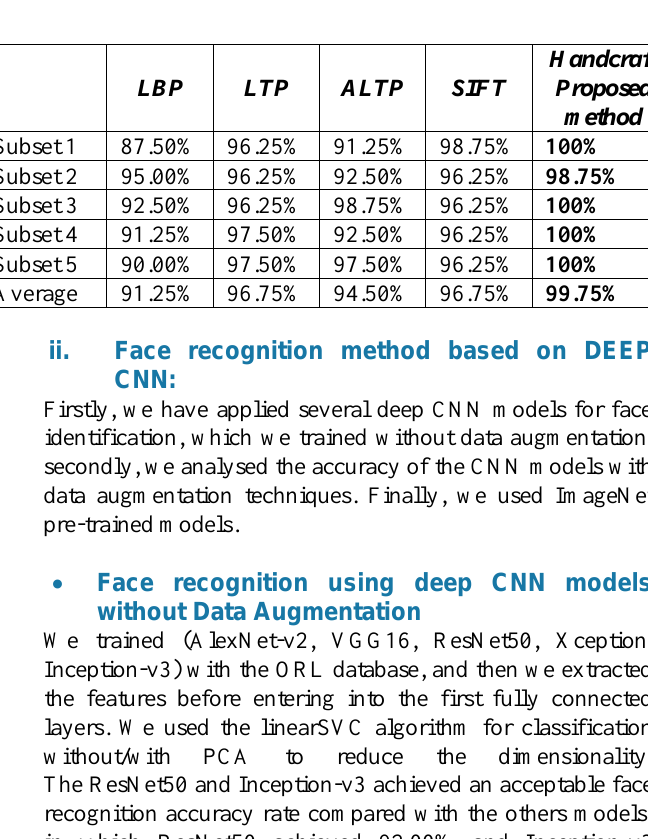
Table 1. Recognition accuracy ratio of handcraft methods on the ORL